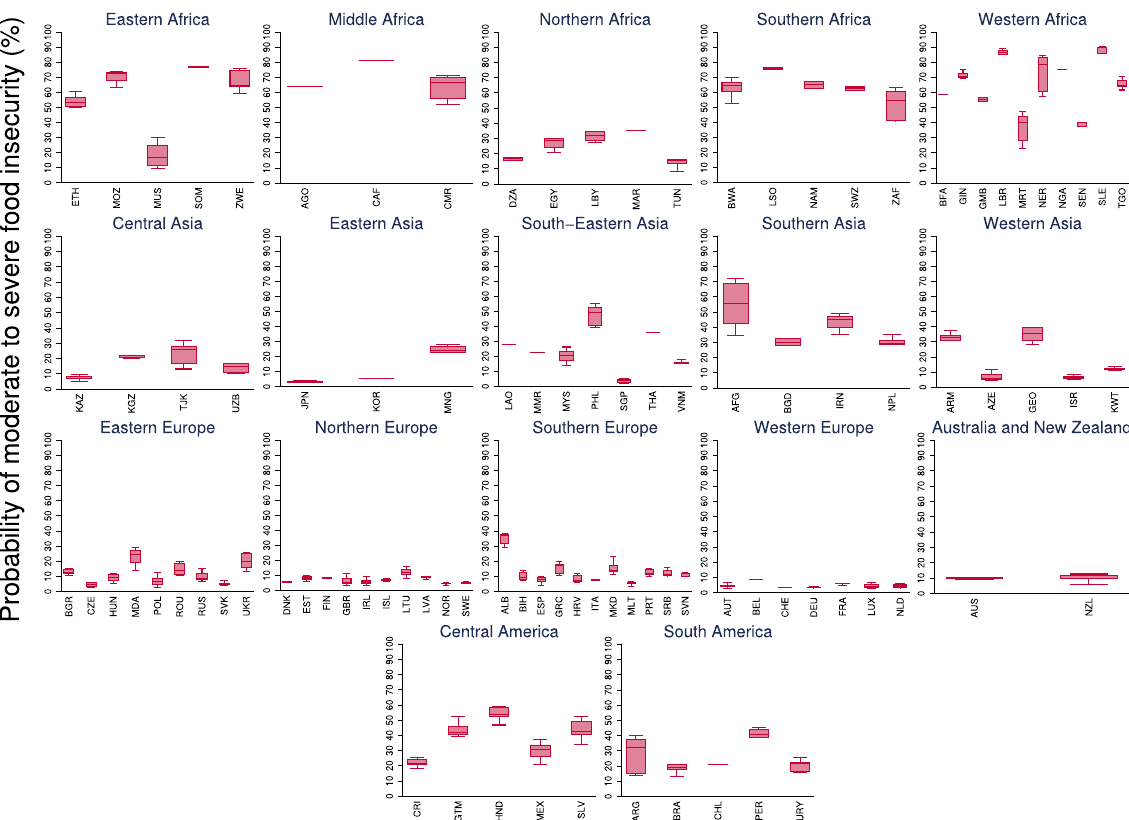
Figure 1. Probability of moderate to severe food insecurity (%) across regions. The global average during 2014–2019 was